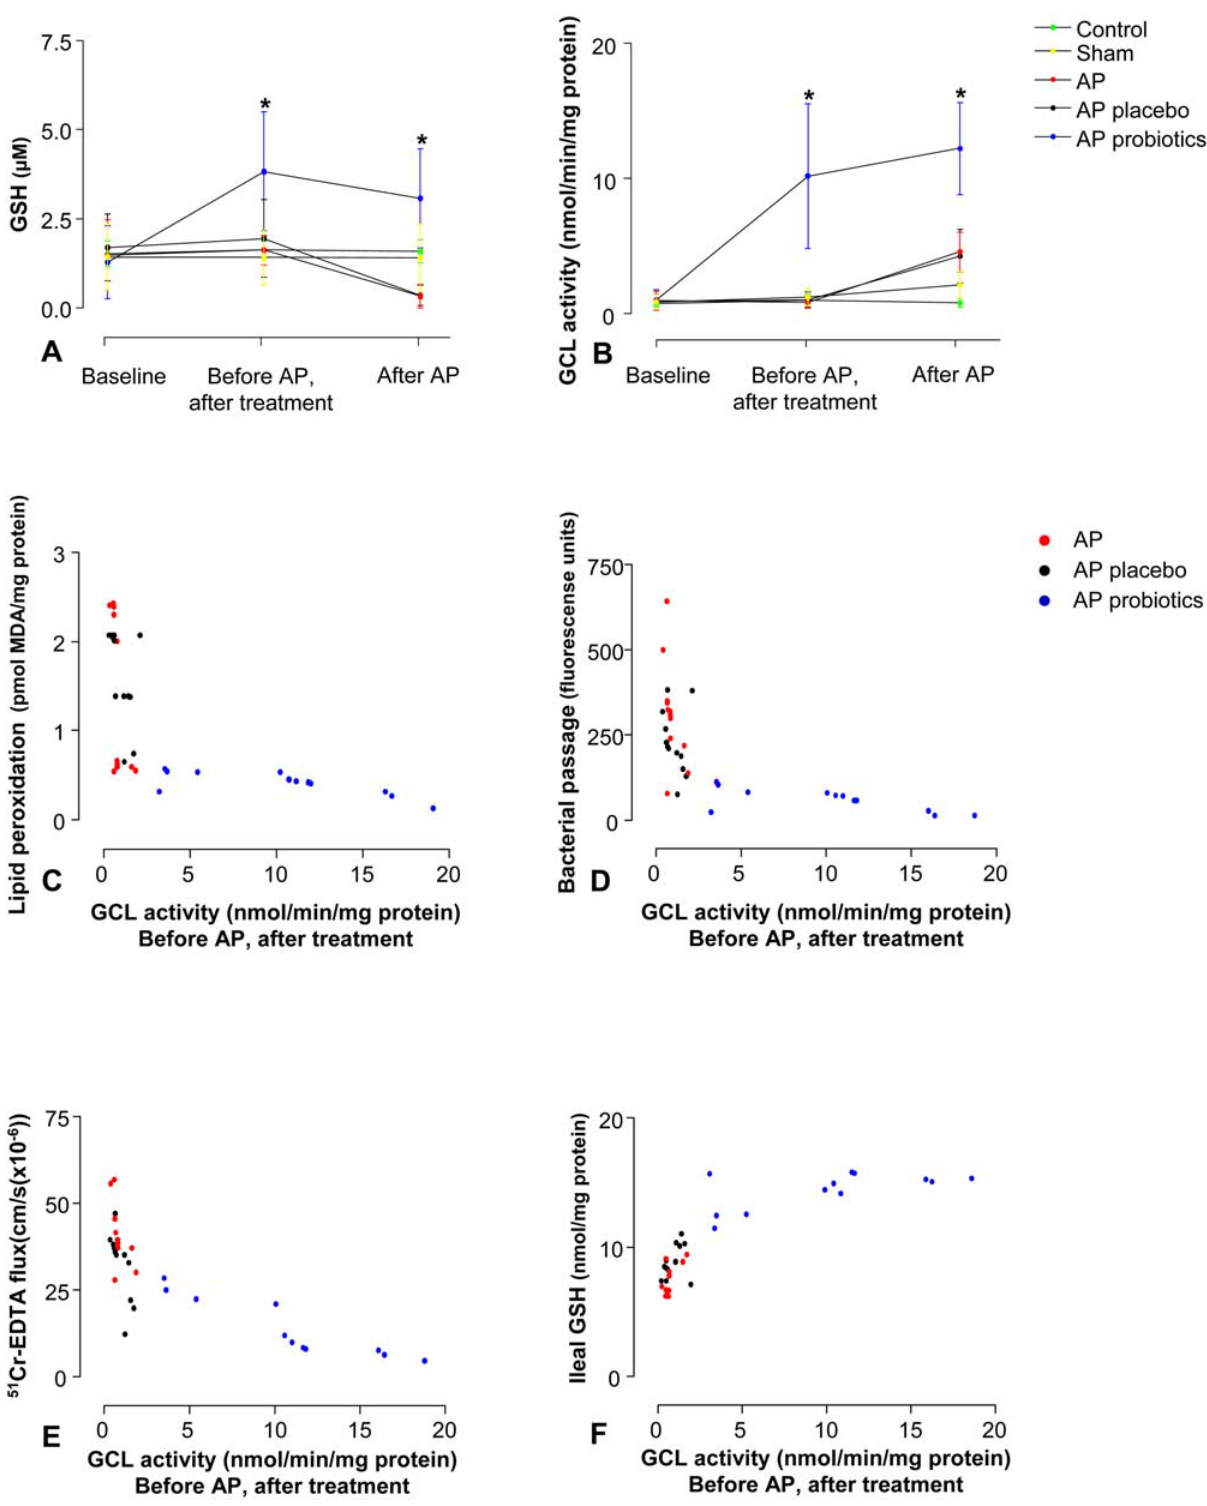
Figure 8. Probiotics induce systemic increase in GSH levels and GCL activity. After 5 days of pre-treatment with placebo (pla, n=12) or probiotics (pro, n=12), rats were subjected to acute pancreatitis (AP, n=12), a sham-procedure (n=12) or not operated (control, n=5). Whole blood was sampled 1) before treatment, 2) after 5 days of pre-treatment, immediately before induction of AP and 3) six hours after induction of AP or sham- procedure. Time course of plasma GSH levels (A) and GCL activity in red blood cells (B) was monitored. The graphs show average ( 6 SD). All analyses were run in duplicates. Comparisons were performed using ANOVA followed by Tukey’s HSD. * P , 0.001, probiotics vs. placebo. Associations between (C) ileal lipid peroxidation, (D) bacterial passage, (E) 51 Cr-EDTA flux, (F) ileal GSH content six hours after induction of AP and GCL activity in red blood cells immediately before subjection to AP.